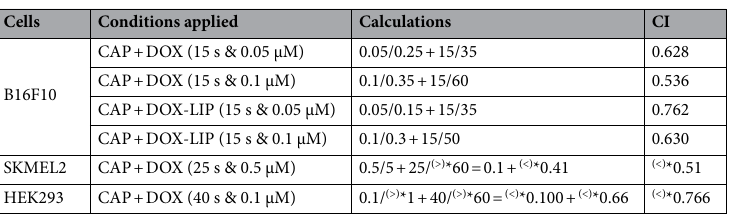
no CAP) revealing that the mechanism of DOX uptake by cells and nucleuses may be modulated by CAP. The FIs estimated from the micrographs (by Image J software 1.8.0) are in Fig. 3e; as seen, CAP treatment does not confer any significant difference in FI ( p > 0.05).